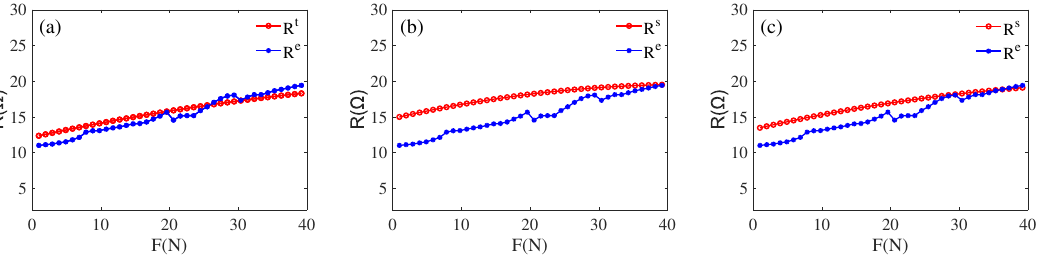
Figure 18. ( a ) R e and R s by inscribed circle; ( b ) R e and R s by circumcircle; ( c ) R e and R s by average.